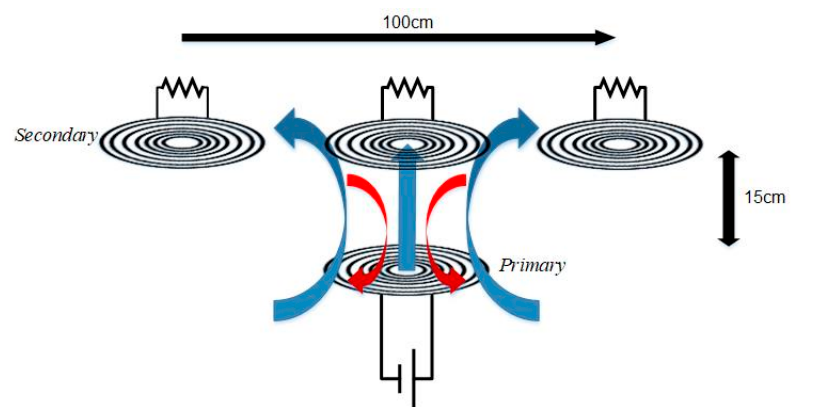
Figure 6. Scenario of a dynamic movement.